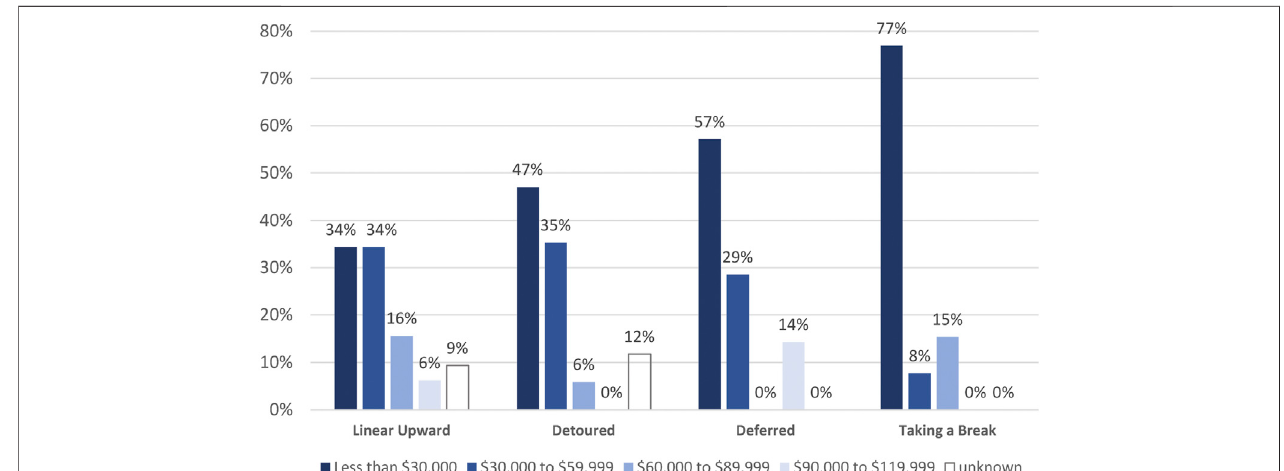
FIGURE 2 | Percentage of program participants on the four momentum trajectories by family income.